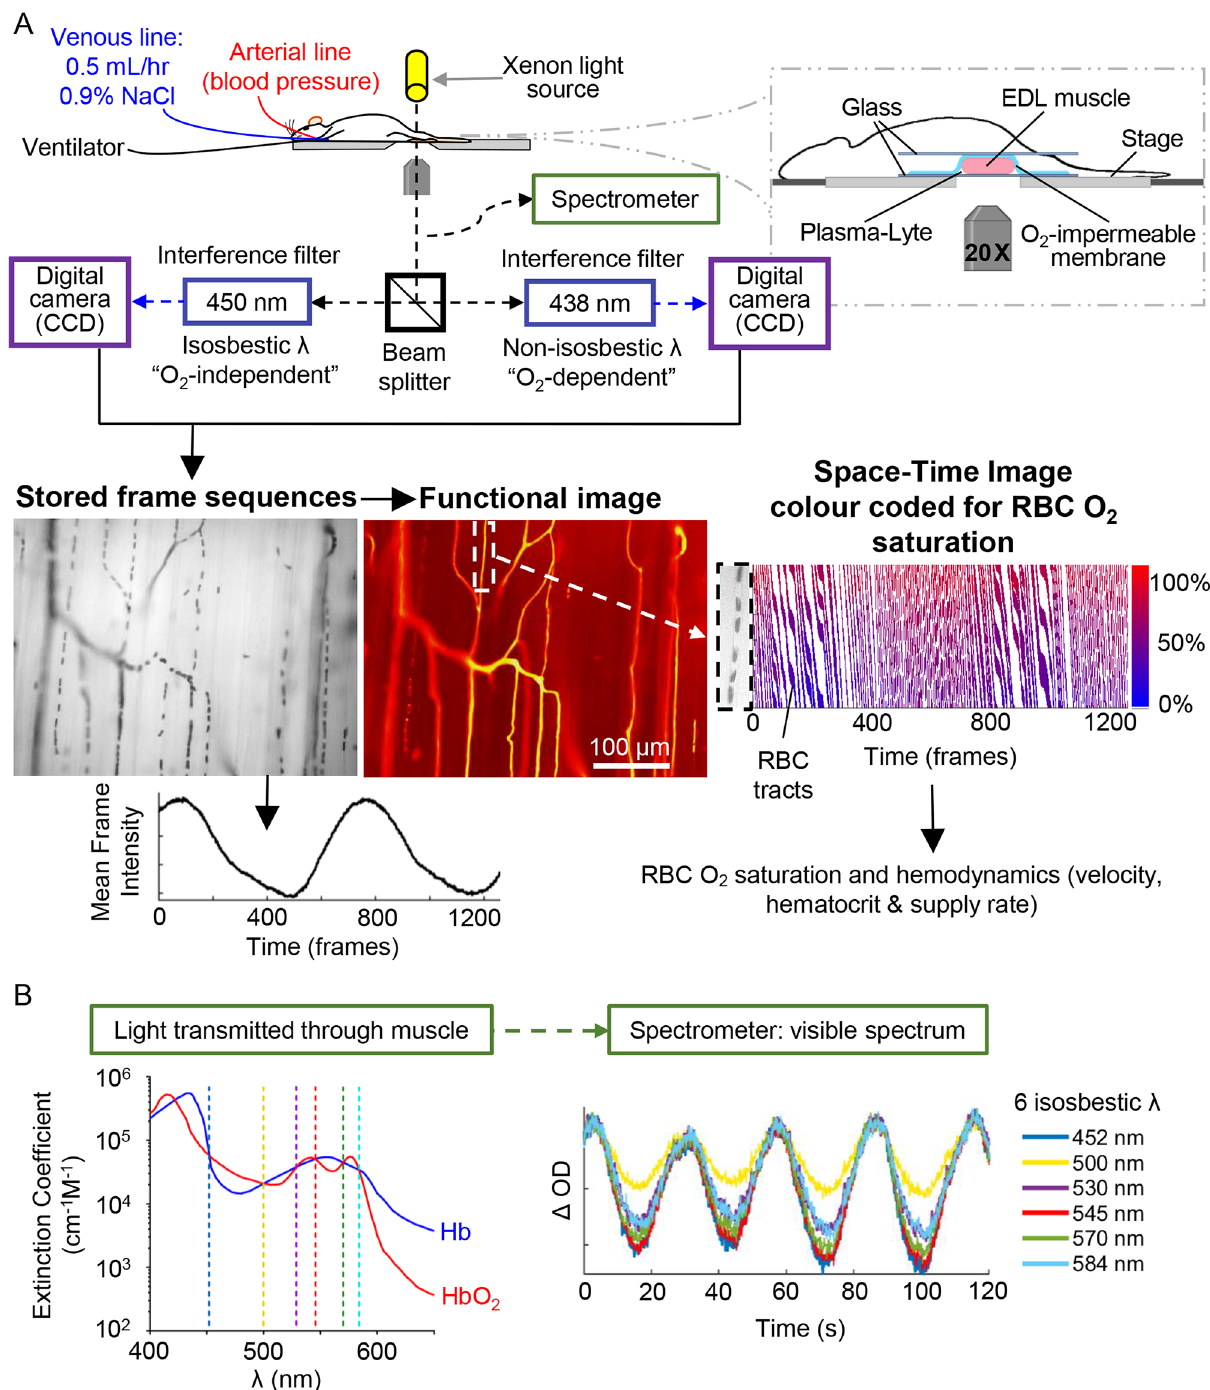
Figure 1. Stage setup and image analysis. Intravital microscopy ( A ): Rats were positioned on a stage with the isolated extensor digitorum longus (EDL) muscle in the light path. Light transmitted through the muscle was split between two cameras and captured at two λ that allow for calculation of RBC O 2 saturation based on spectral properties of fully oxygenated and deoxygenated hemoglobin. Functional images showing the passage of RBCs through capillaries were derived from the captured frame sequences, and space–time images were generated for capillary segments showing RBC transit as tracts colour coded for O 2 saturation. RBC dynamics were calculated from these space–time images. As well, the mean intensity of each captured frame at 450 nm was measured. Spectroscopy ( B ): the intensities of 6 λ isosbestic for fully oxygenated/deoxygenated hemoglobin were measured from light transmitted through the muscle for each field of view after microscopy